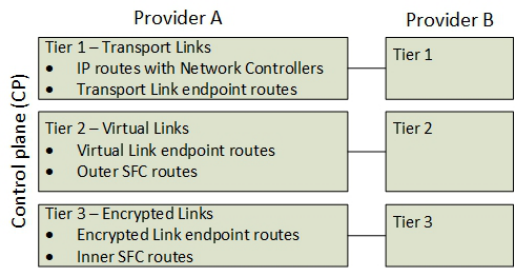
Figure 7. Multiple levels of communication